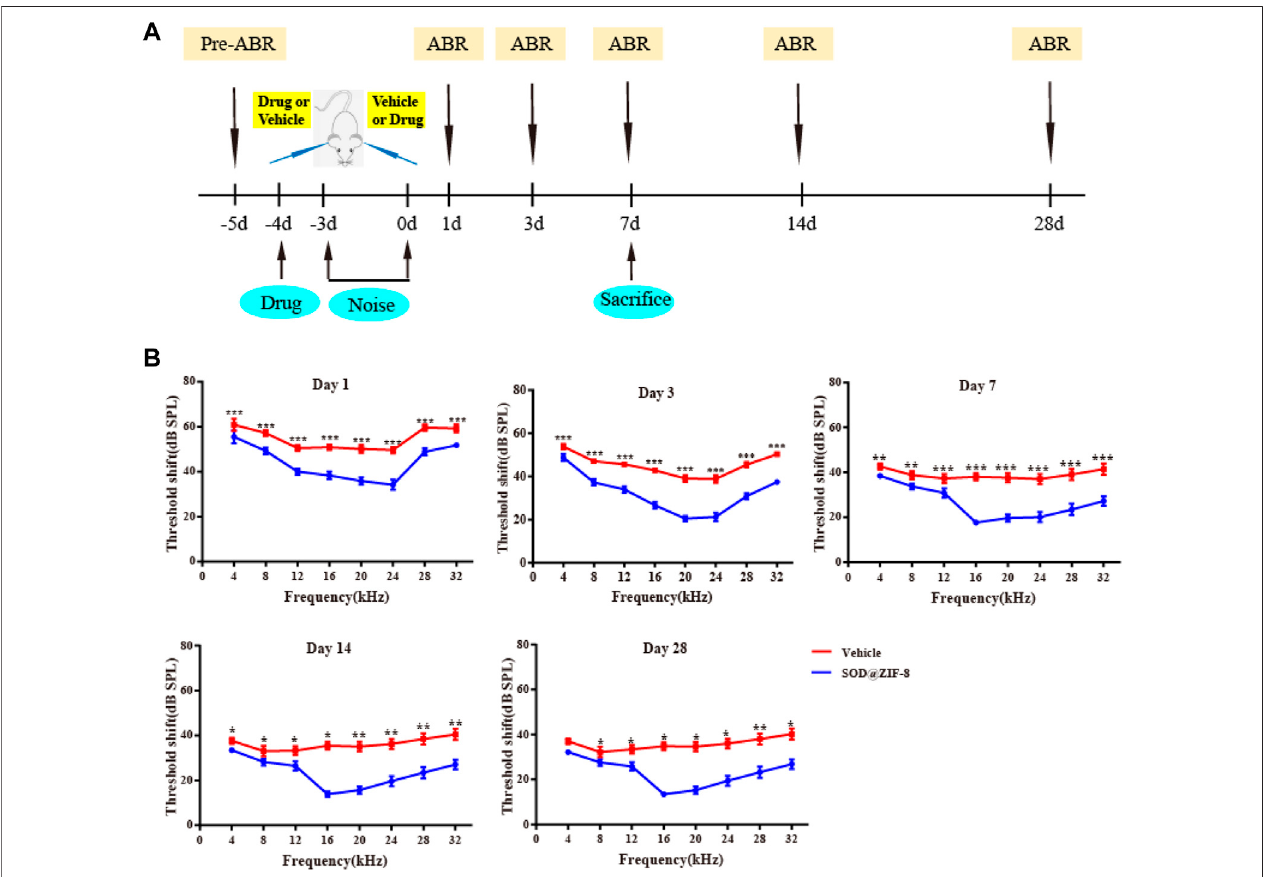
FIGURE 3 | Superoxide dismutase (SOD)@zeolite imidazolate framework-8 (ZIF-8) protected against noise-induced hearing loss (NIHL). (A) Experimental design. (B) Graphsshowmeanthresholdshifts(means±standarderrorofmean)acrossallfrequencies(4,8,12,16,20,24,28,and32 kHz)analyzedatdays1,3,7,14,and28 in animals exposed to noise and treated with SOD@ZIF-8 or vehicle (* p < 0.05, ** p < 0.01, and *** p < 0.001). Days 1, 3, and 7 ( n = 24), days 14 and 28 ( n = 6).